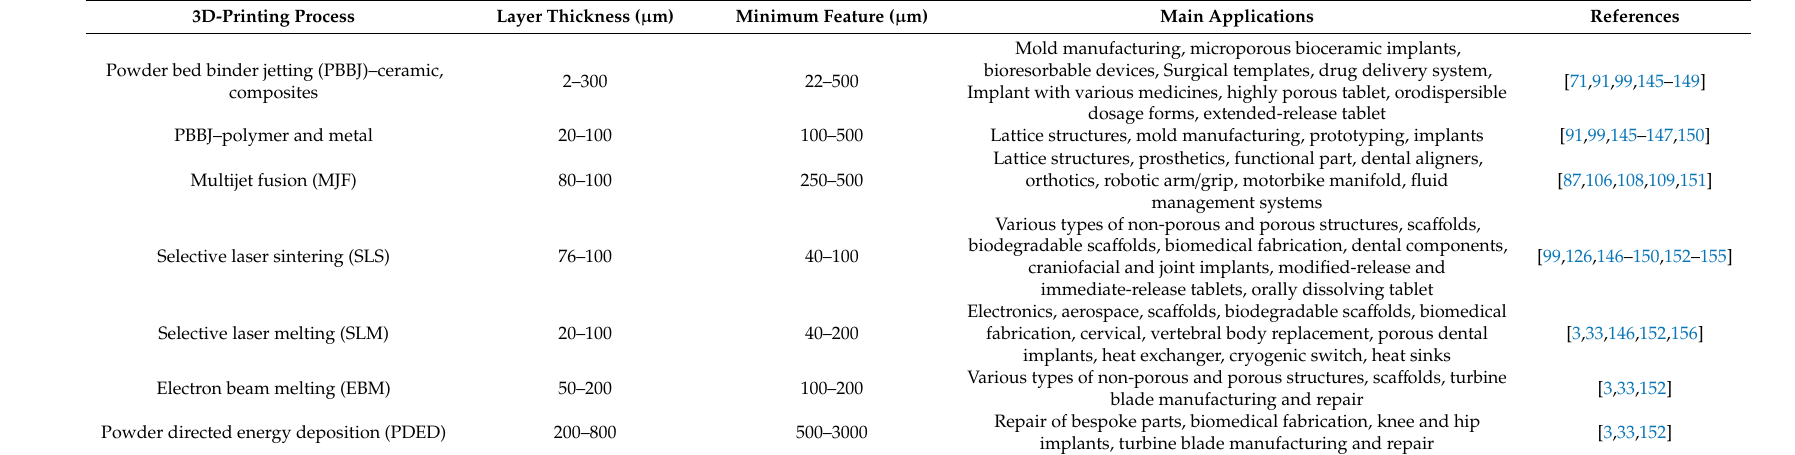
Table 1. Di ff erent powder-based 3D-printing process capabilities and